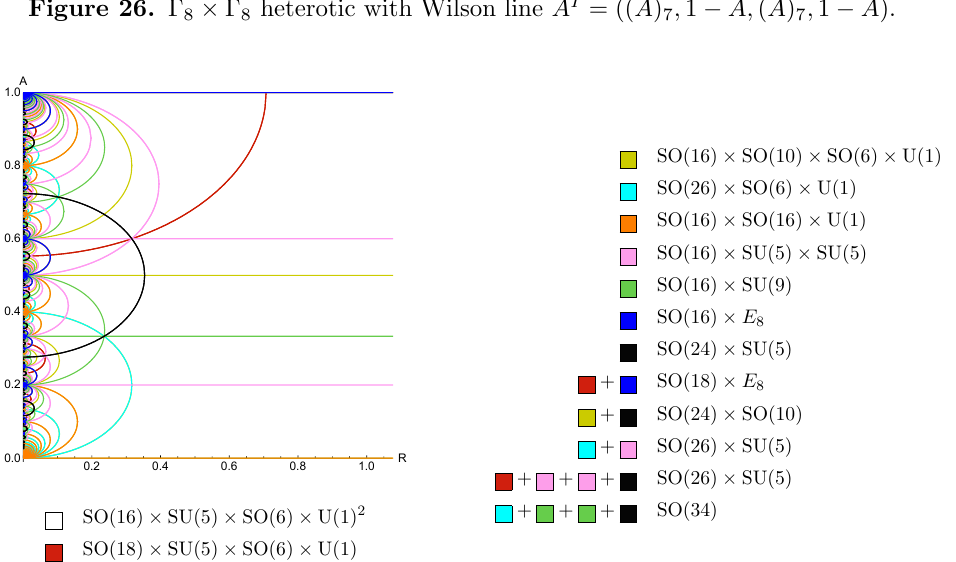
Figure 27. (cid:0) 8 (cid:2) (cid:0) 8 heterotic with Wilson line A I = ( A (cid:0) 1 ; ( A ) 4 ; 0 10 ; 1).